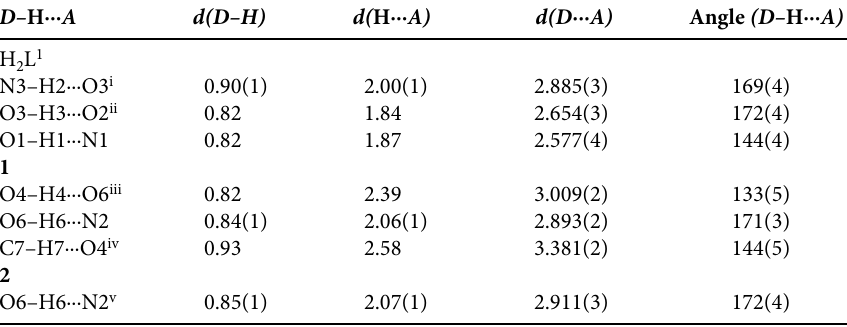
Figure 6. Crystal structure of complex 2 , with hydrogen bonds indi- cated by dotted lines. Table 3. Hydrogen bond values for the compounds